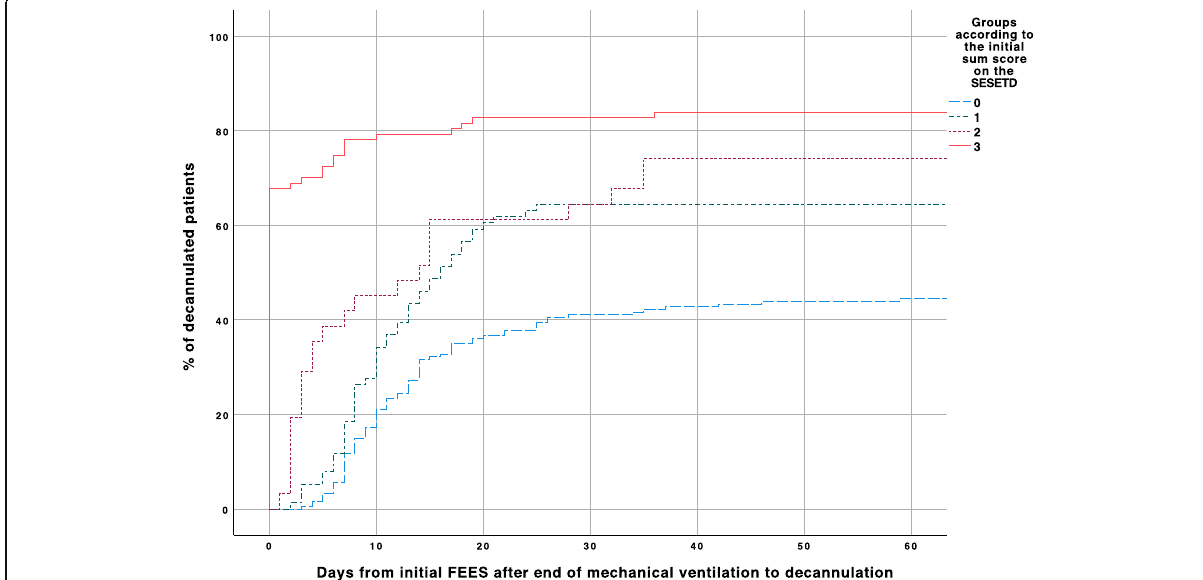
Fig. 3 Distribution of decannulation according to the initial score on the SESETD (0; 1; 2; 3) and depending on the time between initial FEES and decannulation (days); SESETD=Standardized Endoscopic Swallowing Evaluation for Tracheostomy Decannulation in Critically Ill Neurologic Patients; Log Rank p <0.000; Score 0: n =180; Score 1: n =78; Score 2: n =31; Score 3: n